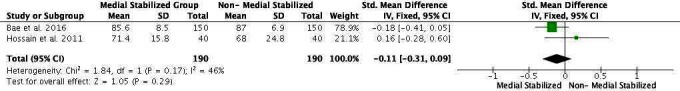
 Forest plot of final WOMAC value of medial stabilized group and non-medial stabilized group (SD: Standard Deviation; CI: Confidence Interval).